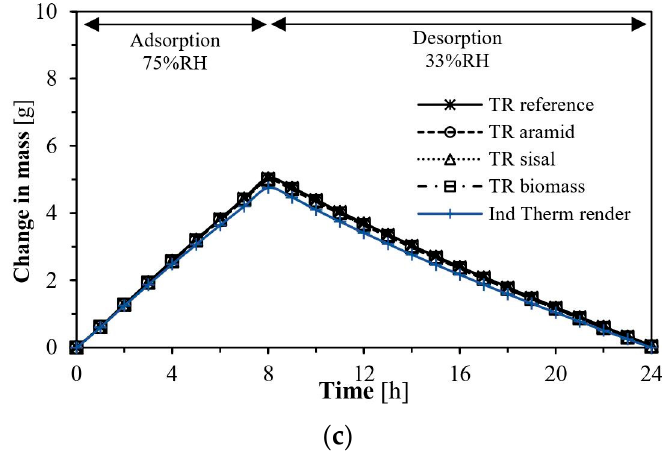
Figure 8. Moisture buffering performance for different applications: ( a ) thermal render; ( b ) thermal render + gypsum board; ( c ) thermal render + protective coating system—Ind thermal render from [62].